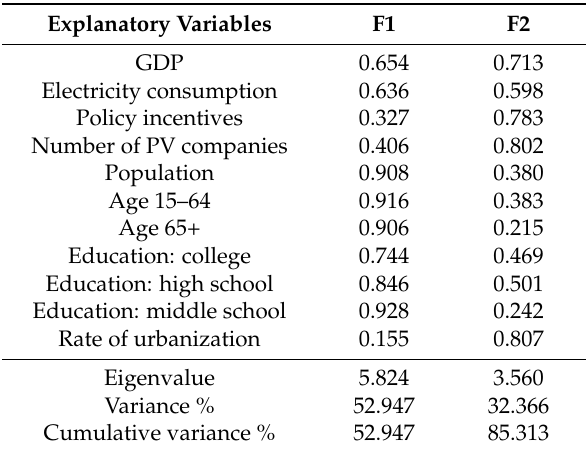
Table 2. The results of PCA (principle component